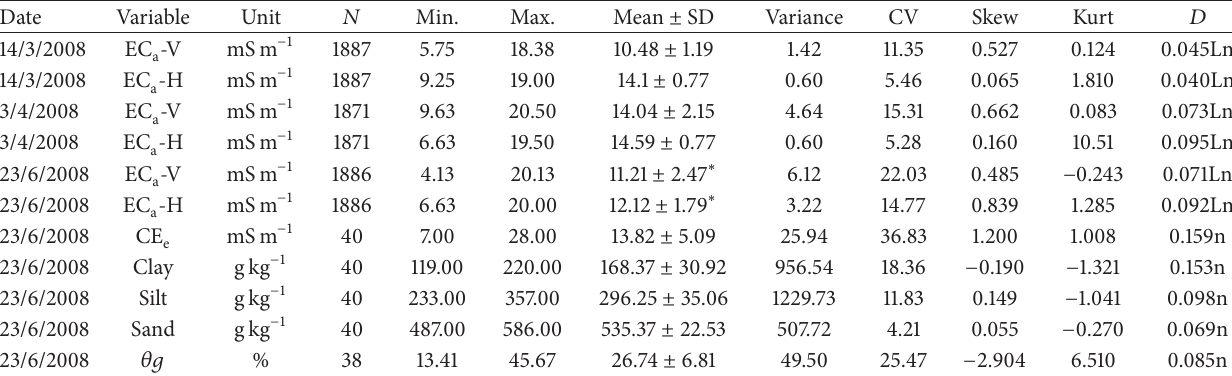
data sets and the soil properties a